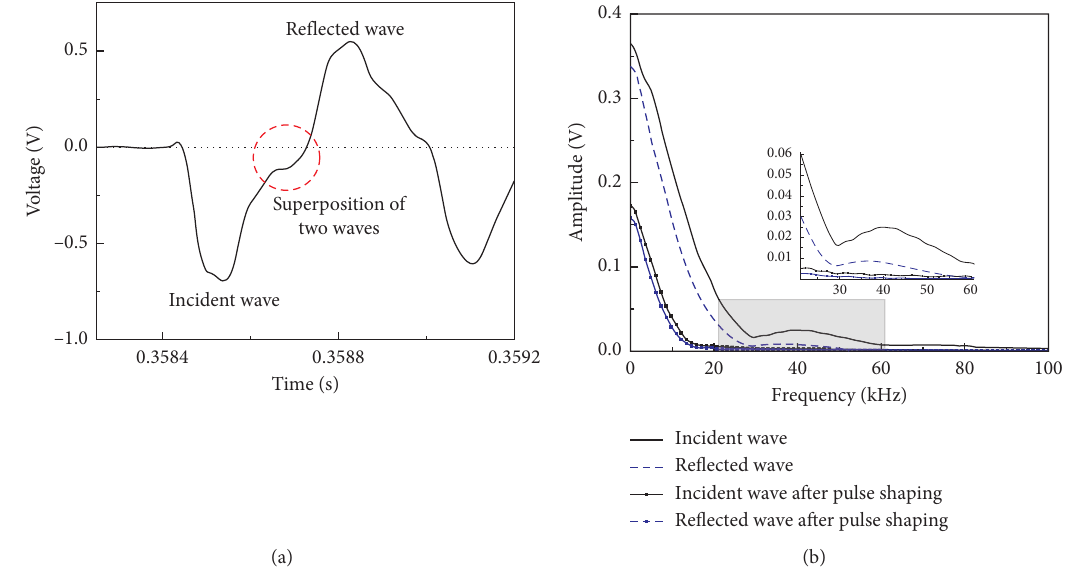
Figure 3: Results of preliminary experiment with an emission pressure of 350 kPa. (a) Signal on the incident bar. (b) Amplitude-frequency relationship.